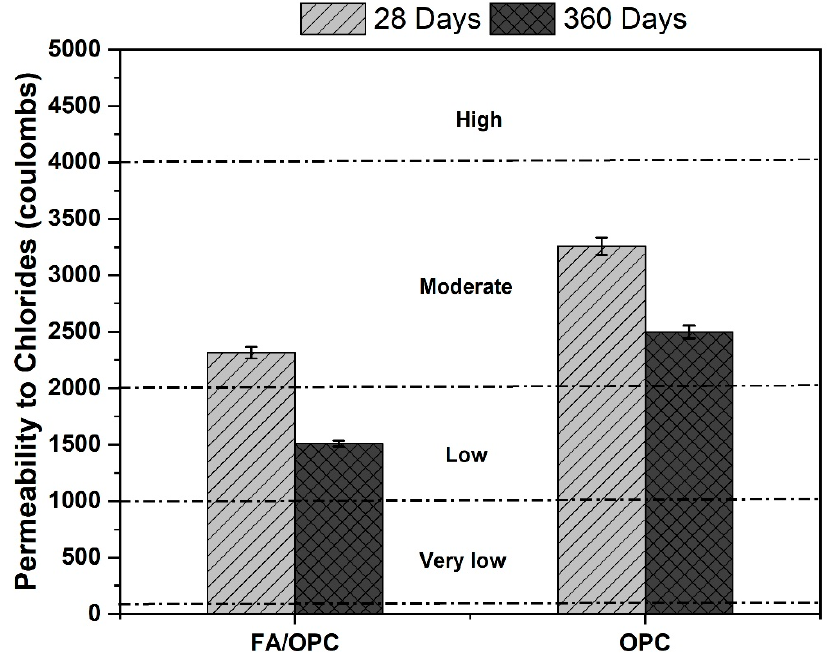
Figure 9. Rapid chloride permeability of the FA / OPC and OPC concrete at 28 and 360 days of curing.